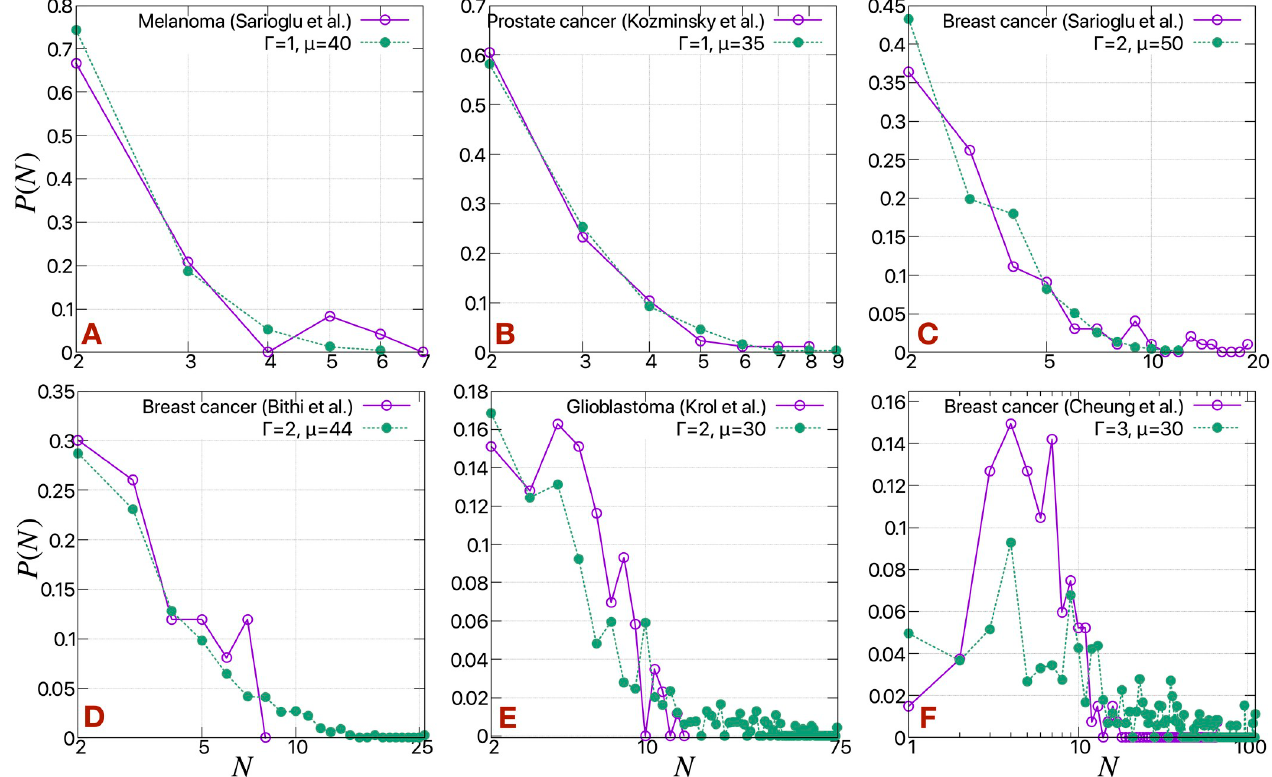
Fig 4. Cluster size distributions compared with experimental results. Cluster size distributions ( P ( N )) of H cells for different values of Γ and μ compared with the circulating tumor cell (CTC) cluster size distributions taking from different experiments. The distributions are normalized such that ∑ P ( N ) = 1. The N axes are in log